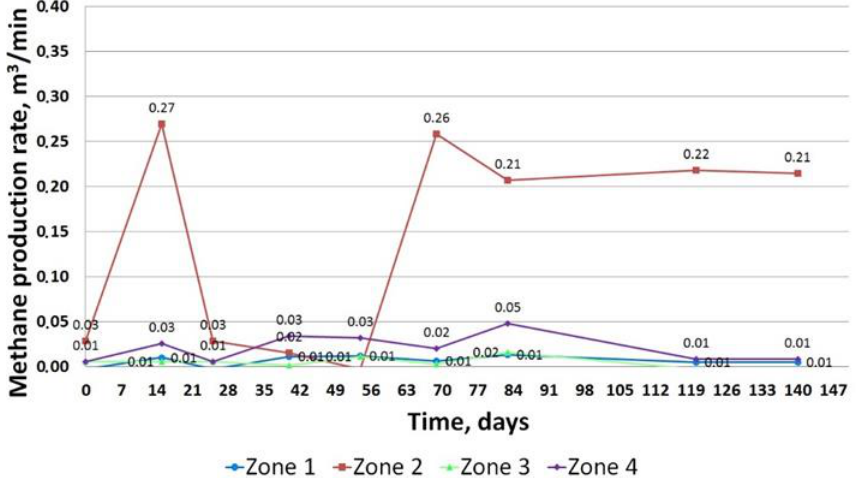
Figure 3. Time-related changing flow rate of methane from various effective length boreholes observed in ventilation raise 2460.